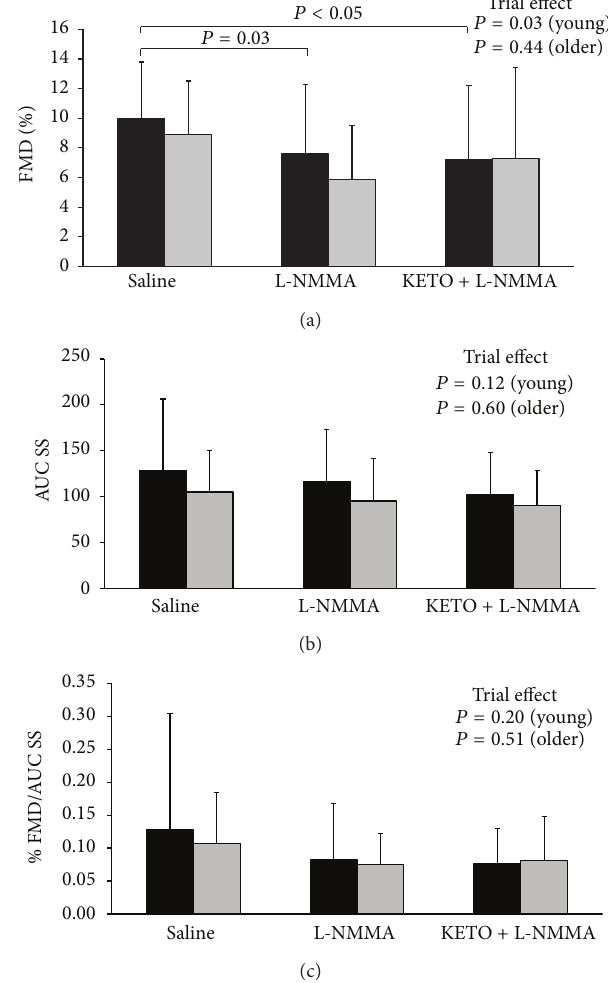
Figure 1: Group means ± SD for young (data from young partici- pants have been published previously [8]) ( 𝑛 = 16 ; black bars) and older ( 𝑛 = 10 ; grey bars) adults are shown for FMD (a), AUC SS (b), and FMD/AUC SS (c) with 𝑃 values for trial effects (within each group) and any significant differences between conditions on each graph. 𝑛 = 9 older adults in the KETO + L-NMMA trial. AUC SS: postocclusion shear stress area under the curve; FMD: flow-mediated dilation; L-NMMA: N(G)-monomethyl-L-arginine; KETO: